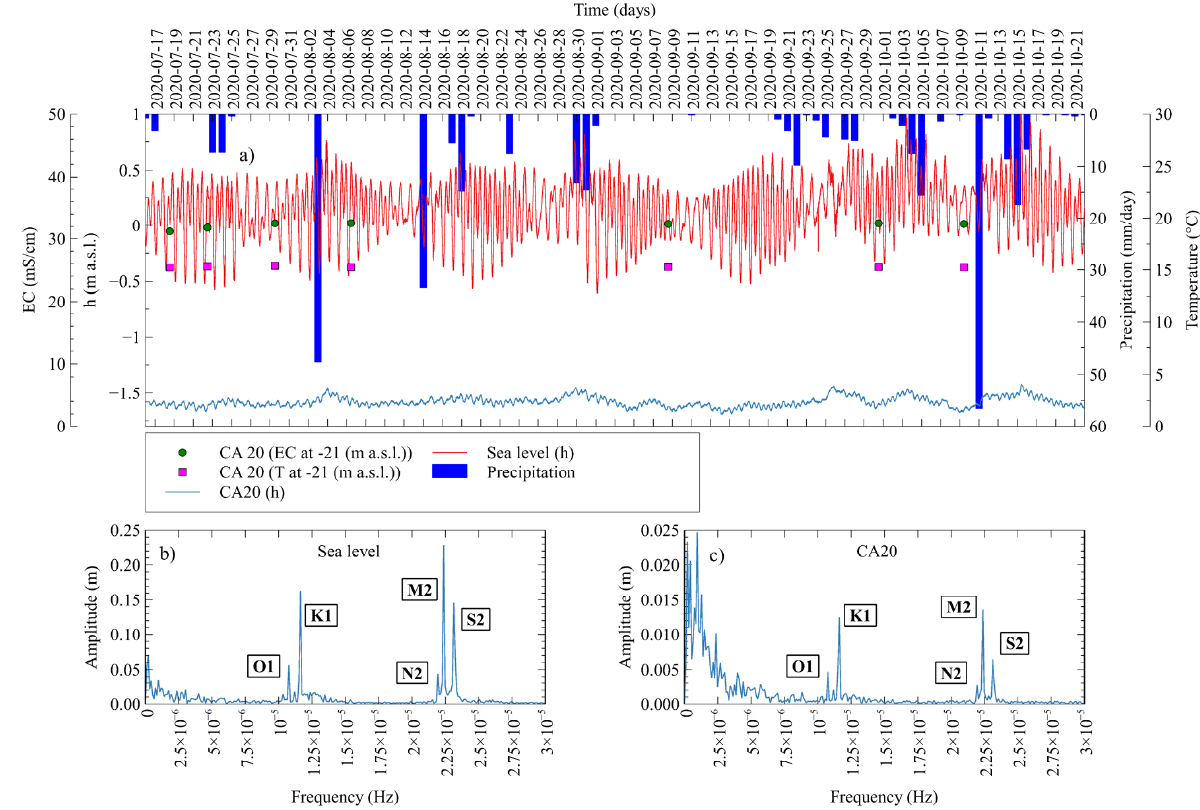
Figure 11. ( a ) Measurements taken at piezometer CA20 compared with the sea level data recorded at the Chioggia tide gauge station and daily precipitation at Sant’Anna (SA); ( b ) resulting amplitude spectral density (ASD) from the Fourier analyses applied to the pressure signal recorded in Chioggia tide gauge station; and ( c ) CA20 h amplitude spectral density